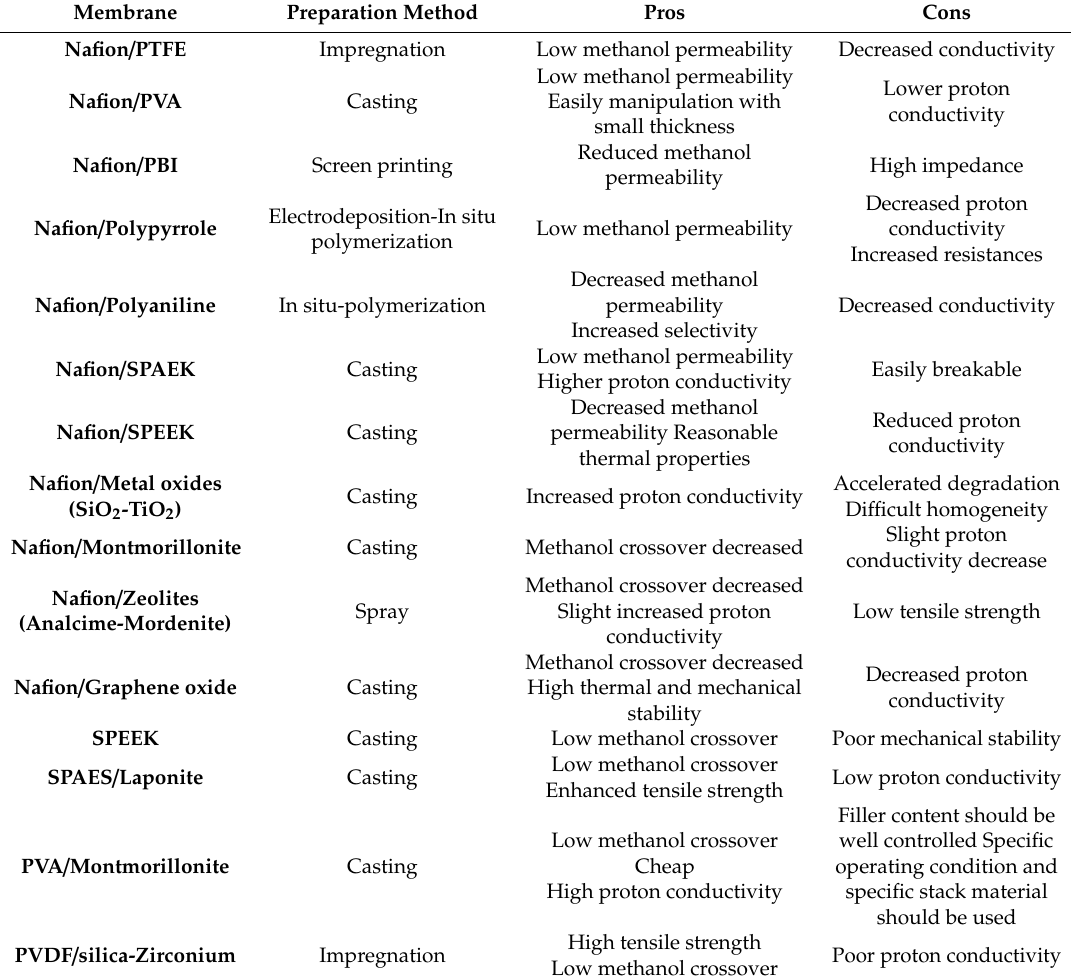
Table 1. Summary of DMFC composite membrane